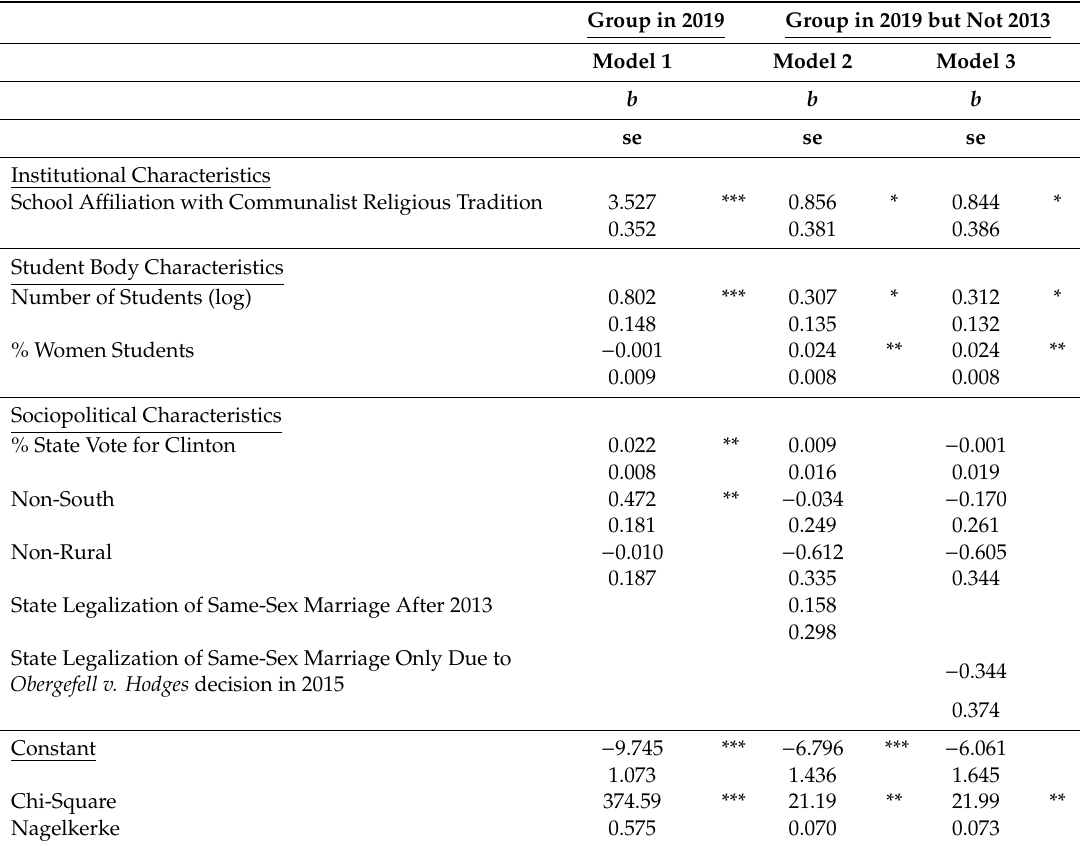
Table 2. Logistic regression analyses of LGBTQ groups at Christian colleges and universities.